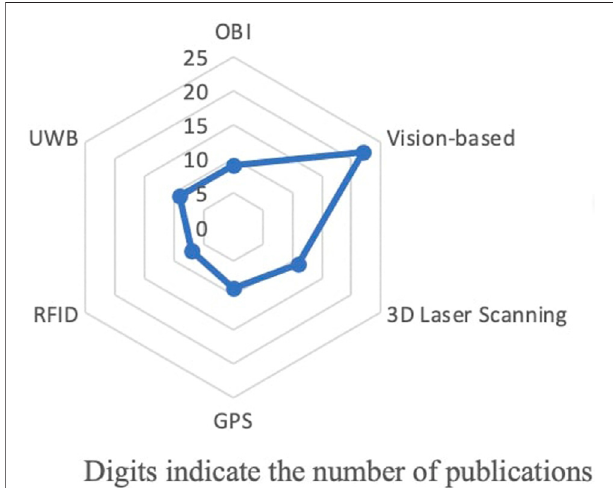
FIGURE 1 | The distribution of technology for monitoring construction